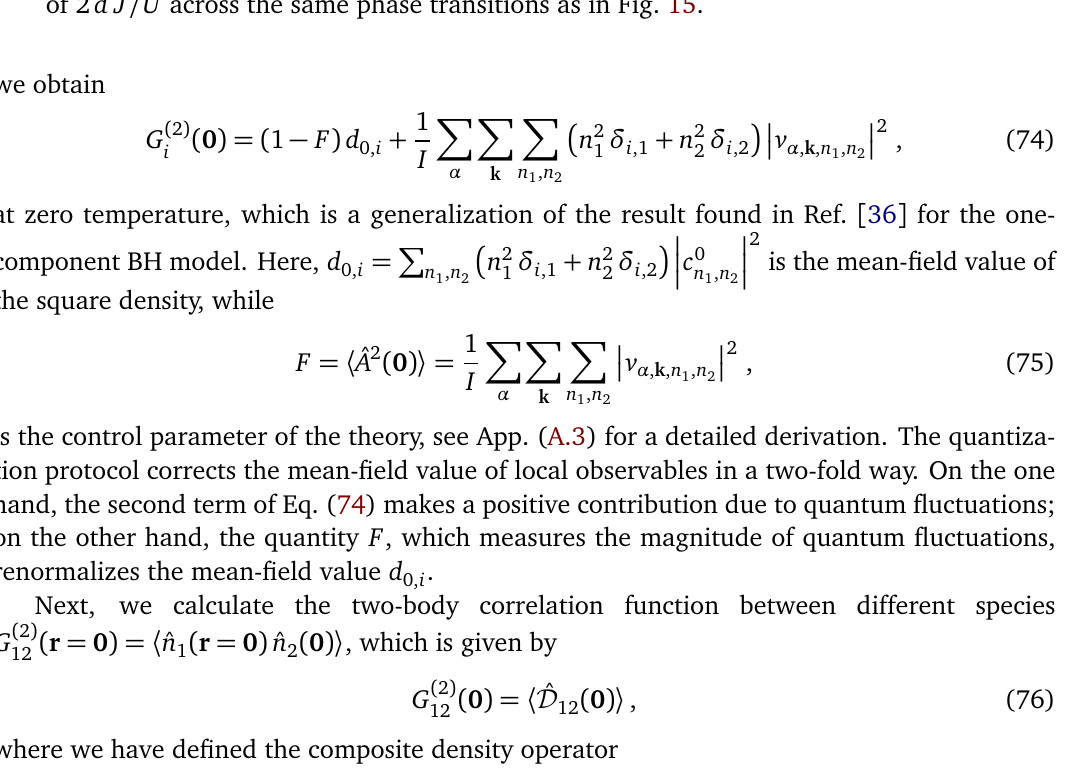
( r = 0 ) evaluated for d = 2 as a function s